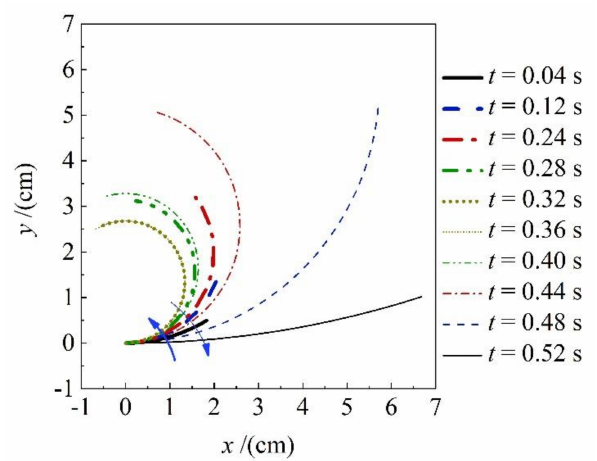
Figure 5. Fitted image of the trajectory of axe foot whip of the adult Solen strictus Gould.